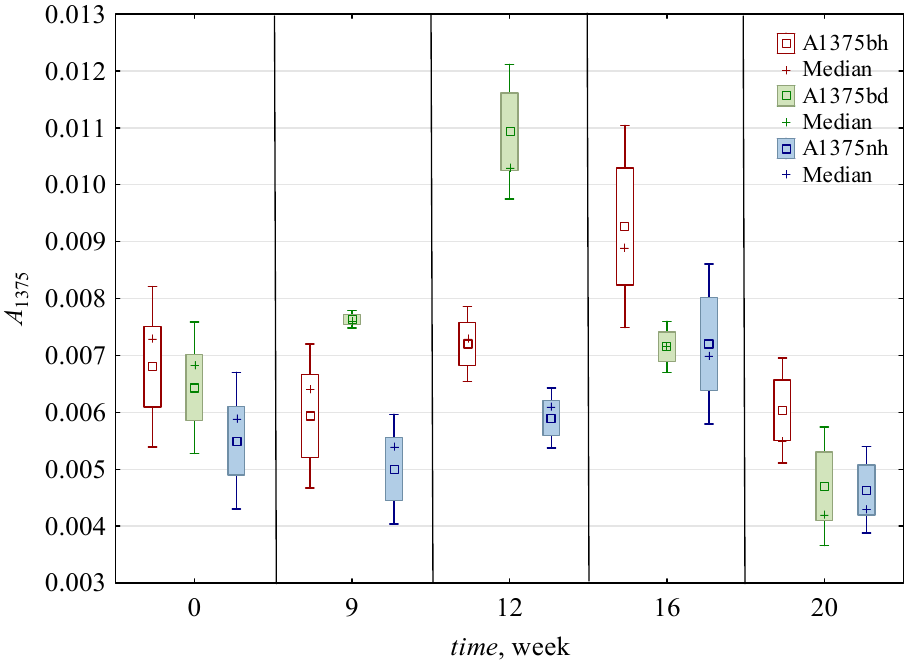
Figure 5. Value of absorbance A 1375 for wavenumber characteristic for holocellulose; b —broad base, n —narrow base, h —peak height, d —peak deconvolution, □ —mean, frame— SE , and whisker— SD . The A 1505 / A 1158 ratio (Figure 6), similar to A 1505 / A 1375 , indicates the amount of lignin